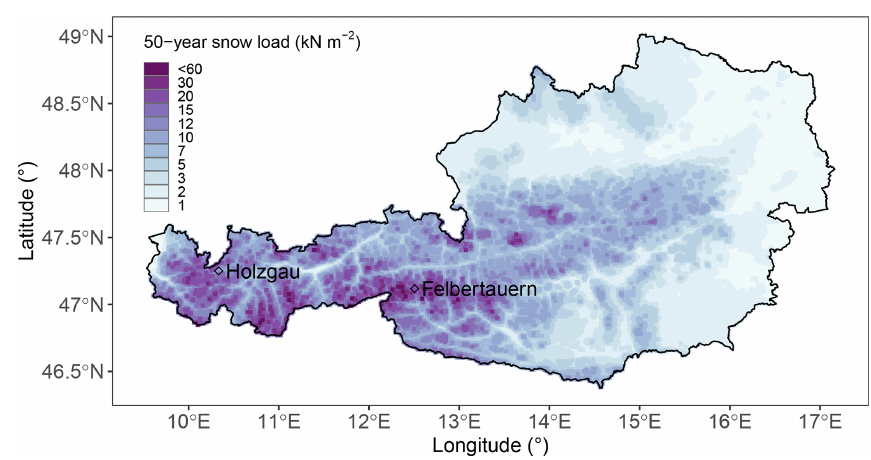
Figure C1. 50-year return levels of snow load in Austria. Two stations with SWE observations are outlined for a qualitative validation. This map is based on 214 snow depth records, (cid:49) SNOW -derived SWE, and smooth spatial modeling of their extremes.